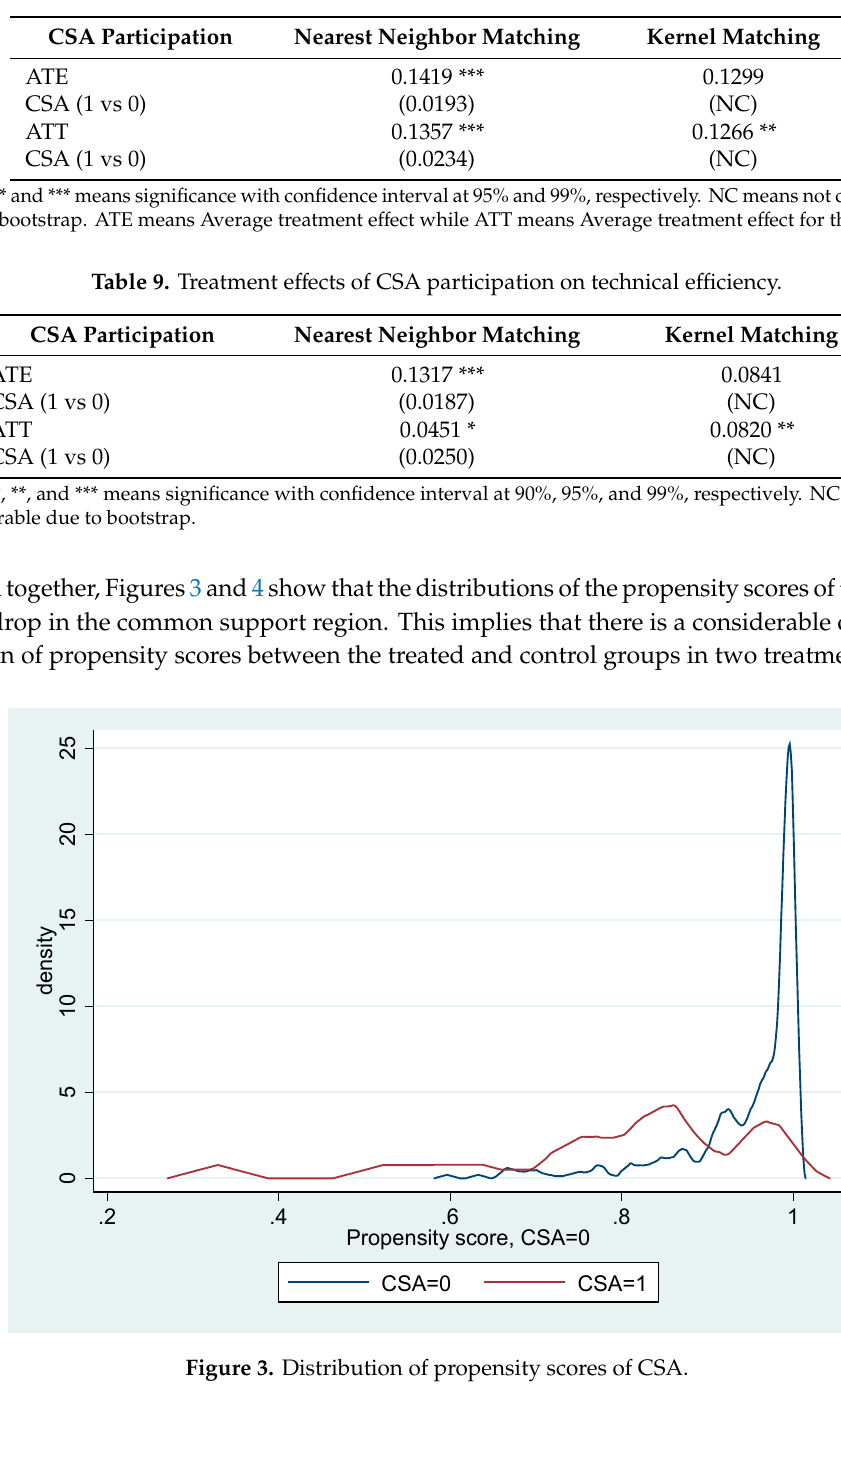
Table 8. Treatment e ff ects of adaptation response on technical e ffi ciency.